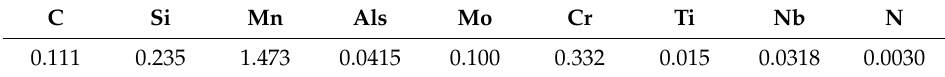
Table 1. Chemical composition of Ti-Nb microalloyed steel, wt